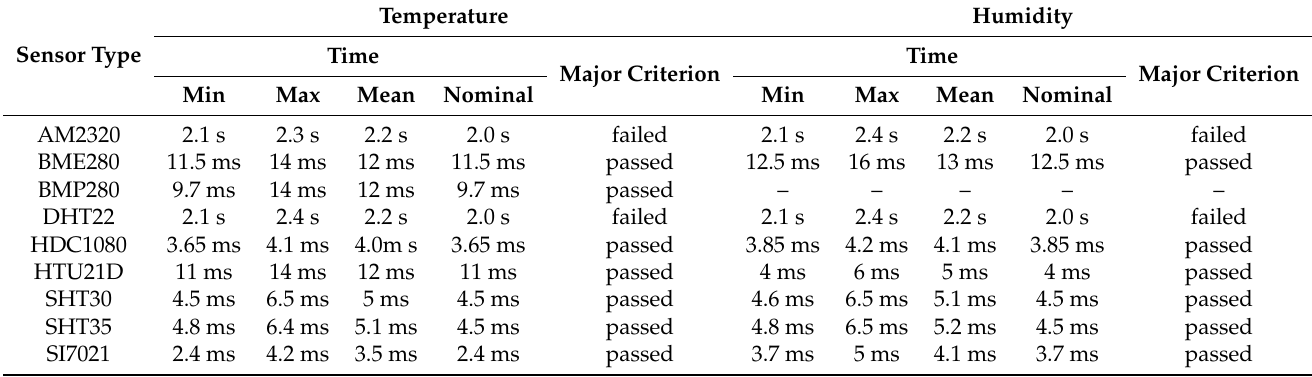
Table 9. Comparison of the response time of temperature and humidity sensors (on the basis of [17]).